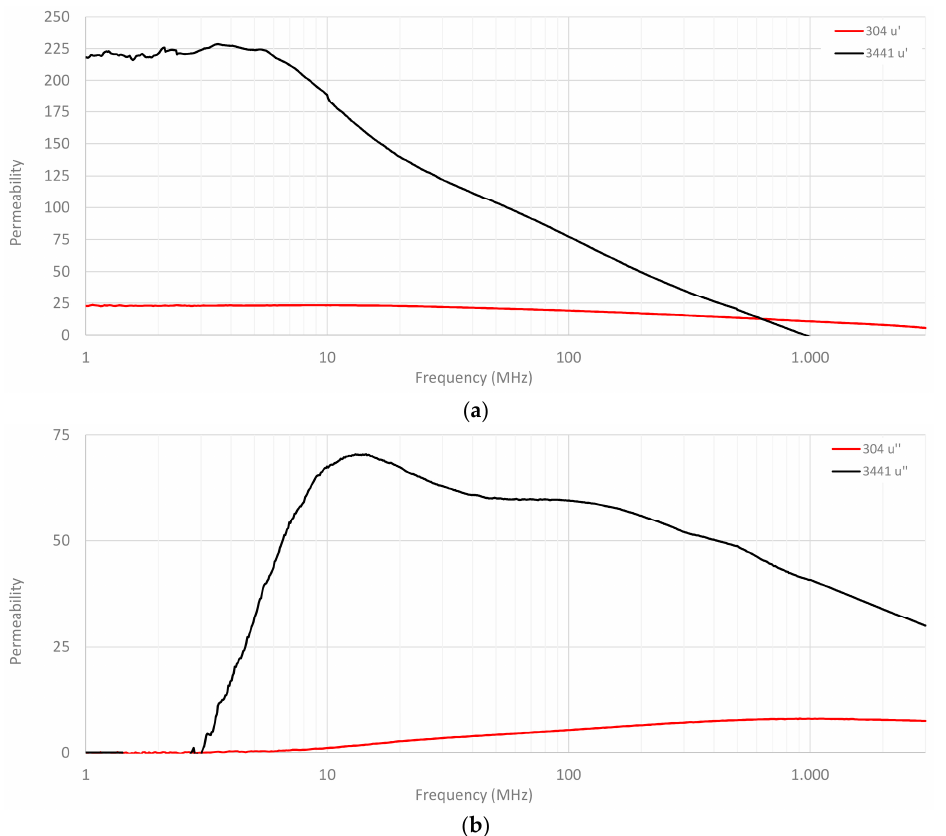
Figure 2. Complex relative permeability profiles of 304 and 3441 materials: ( a ) real part μ ′ ; and, ( b ) imaginary part μ ′′ .